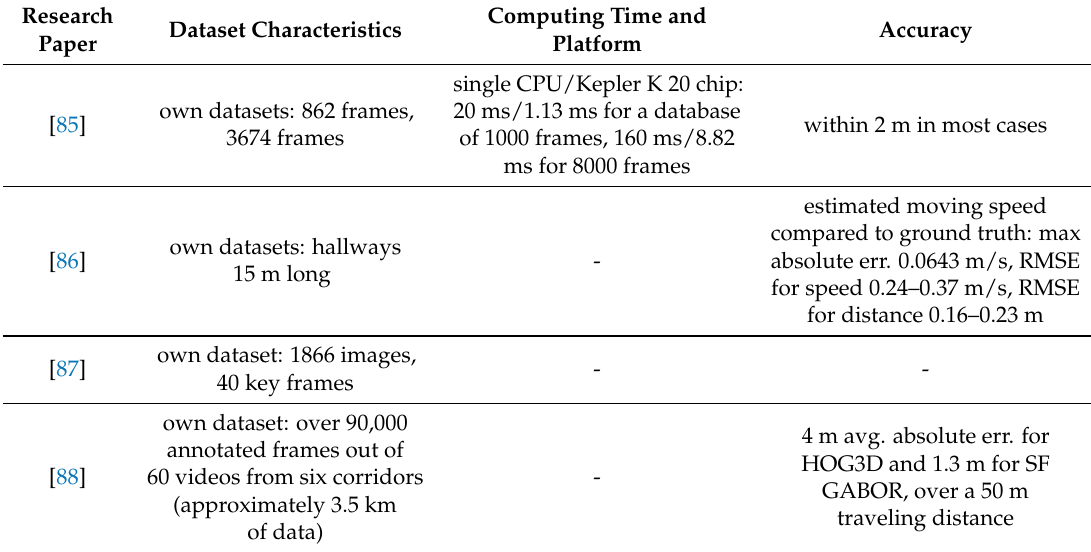
Table 8. Characteristics of indoor localization solutions with real image/feature databases, 2D mobile cameras, and traditional image analysis.